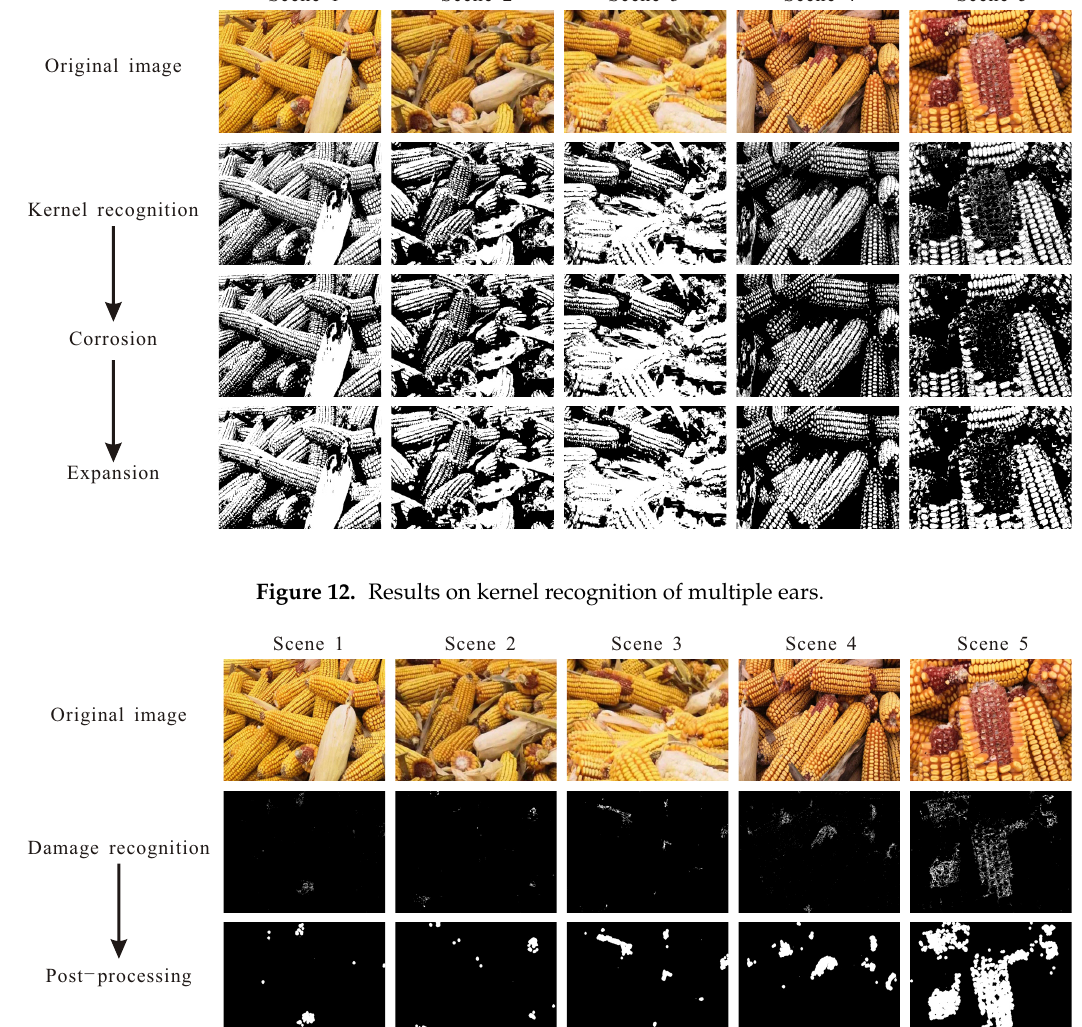
Figure 13. Results on damage recognition of multiple